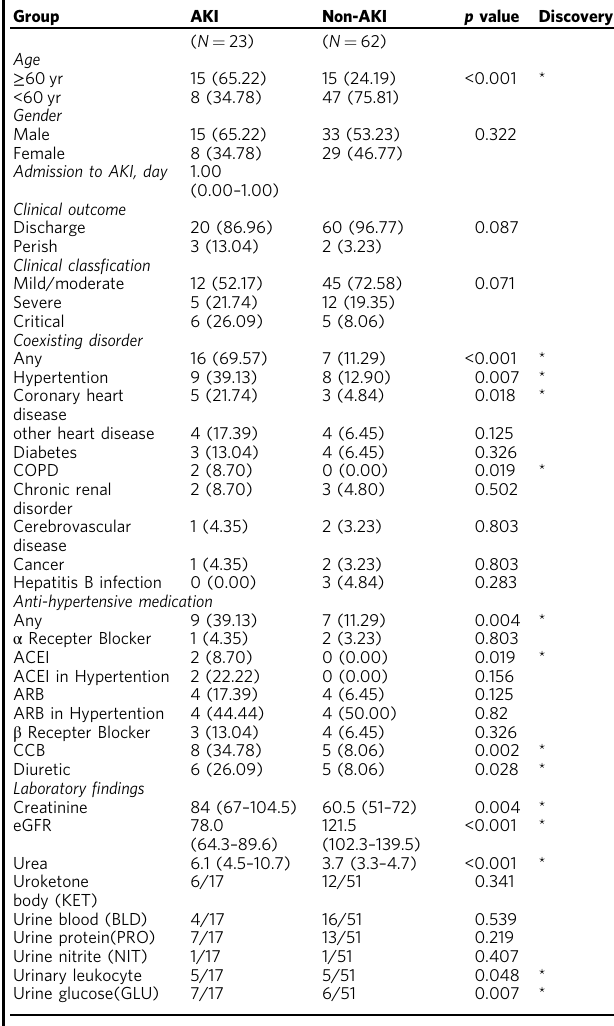
Table 1 Clinical characteristics of COVID-19 patients in this study.